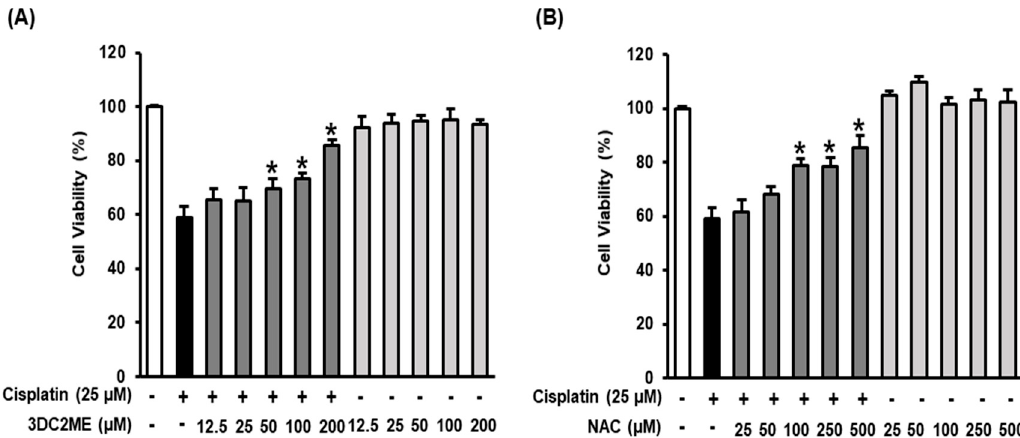
Figure 2. Protective effect of 3DC2ME isolated from Z. jujuba root extract against cisplatin-induced kidney cell damage. ( A ) Effects of 3DC2ME and ( B ) NAC on viability of LLC-PK1 cells exposed to 25 µ M cisplatin for 24 h using the Ez-Cytox cell viability assay (mean ± SD, * p < 0.05 cisplatin-treated LLC-PK1 cells). 3DC2ME, 3-dehydroxyceanothetric acid 2-methyl ester; NAC, N -acetyl cysteine; SD, standard deviation.